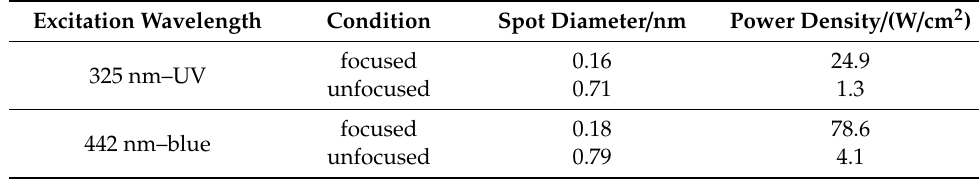
Table 1. List of Gaussian spot diameters and resulting average excitation power densities for the employed laser configurations.